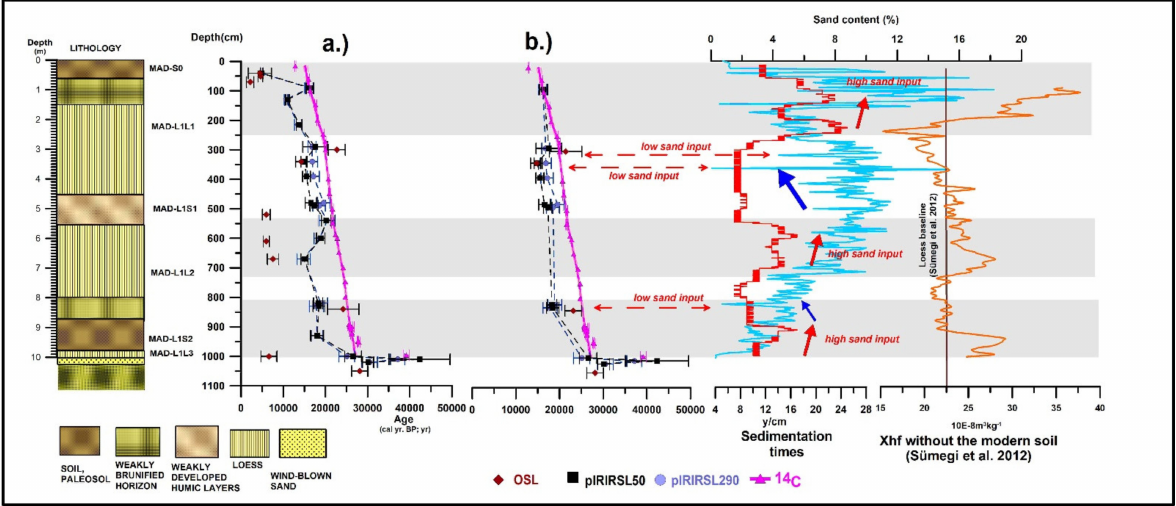
Figure 8. Comparison of 14 C based chronology with quartz OSL, feldspar pIRIRSL ages as well a sand content, sediment accumulation rates derived from 14 C age-depth models and magnetic susceptibility values ( a ) all luminescence data included, ( b ) filtered-note gray bands mark zones of reduced accumulation and increased pedogenesis (Xhf data from